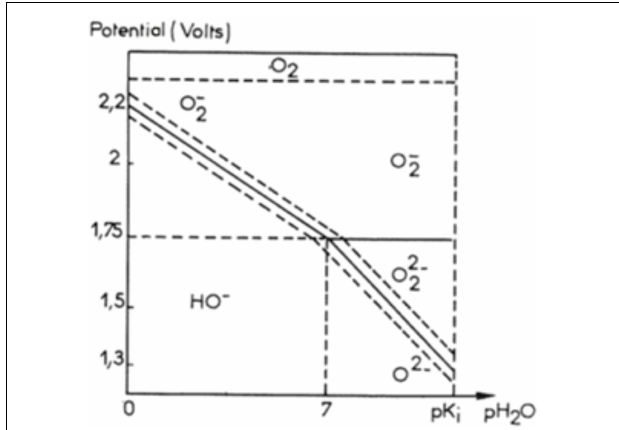
FIGURE 1 | Potential-oxoacidity diagram of oxygenated species in eutectic NaOH-KOH at 227 ◦ C (Goret, 1966). Full line for O 2 − and O 22 − concentrations equal to 10 − 2 M, upper dashed line for 10 − 1 M and lower dashed line for 10 − 3 M.